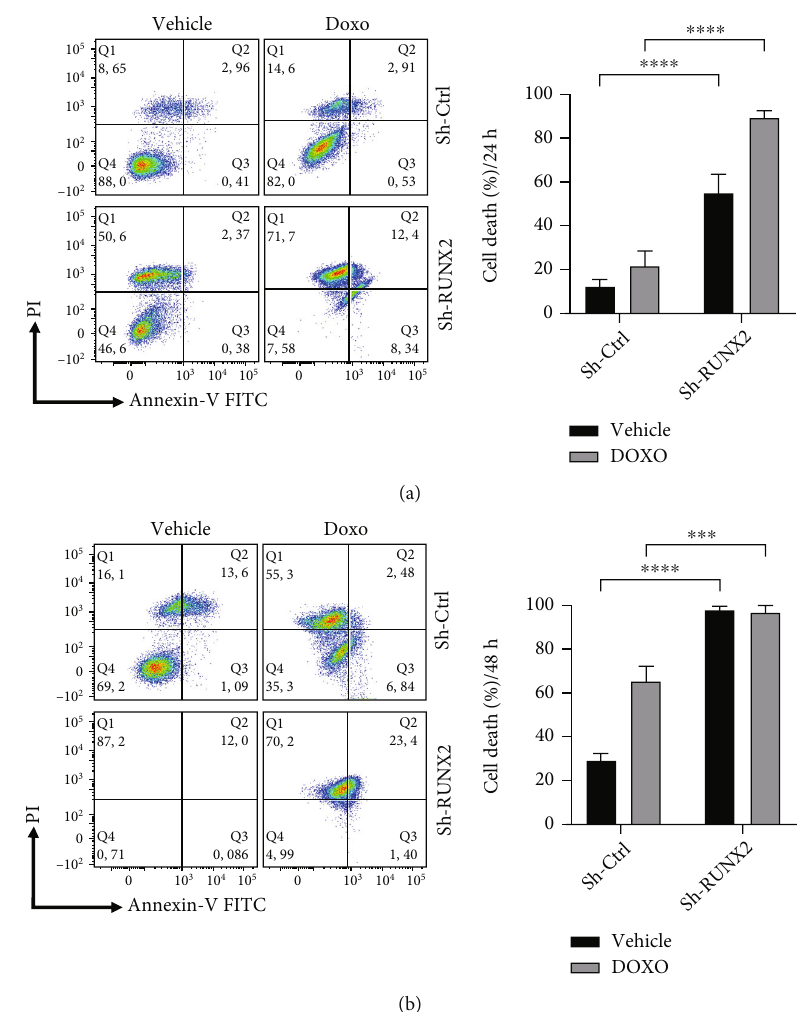
Figure 2: Induction of cell death in A549 lung cancer cells with downregulation of RUNX2 . A549 cells were treated with doxorubicin or vehicle for 24h and 48 h after pretreatment with lentiviral particles coding for sh-RNA against RUNX2 . (a). A representative contour plot of A549 cells treated with DOXO and vehicle for 24 h, pretreated with sh - RUNX2 and sh - Ctrl , and labeled with Annexin V-FICT and PI is shown. (b). A549 cells were treated with DOXO and vehicle for 48 h, pretreated with sh - RUNX2 and sh - Ctrl , and labeled with Annexin V-FICT and PI. Right panels show the percentages of dead cells are shown in bars of media ± SEM (three independent experiments) ∗ p < 0 : 05 , ∗∗ p < 0 : 01 , ∗∗∗ p < 0 : 001